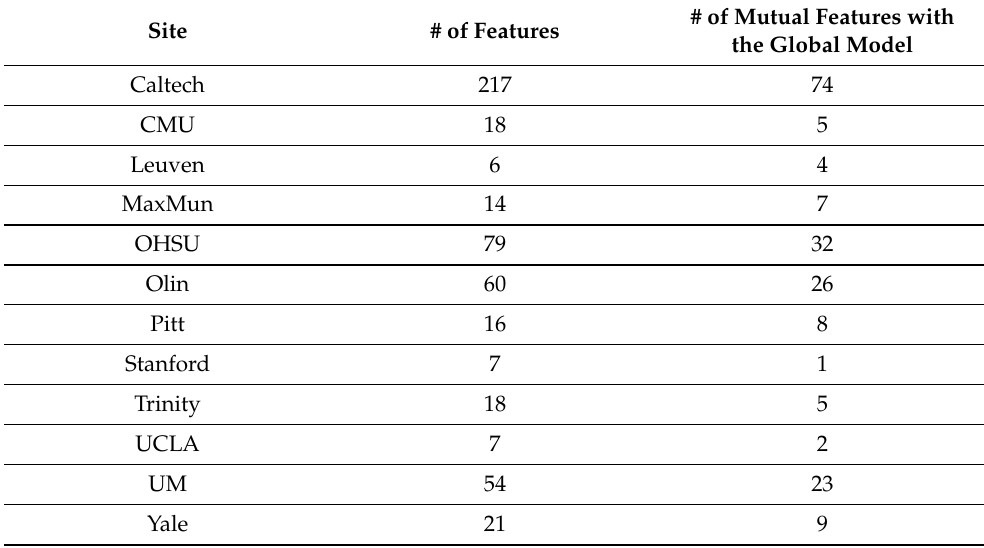
# of Mutual Features with the Global Model